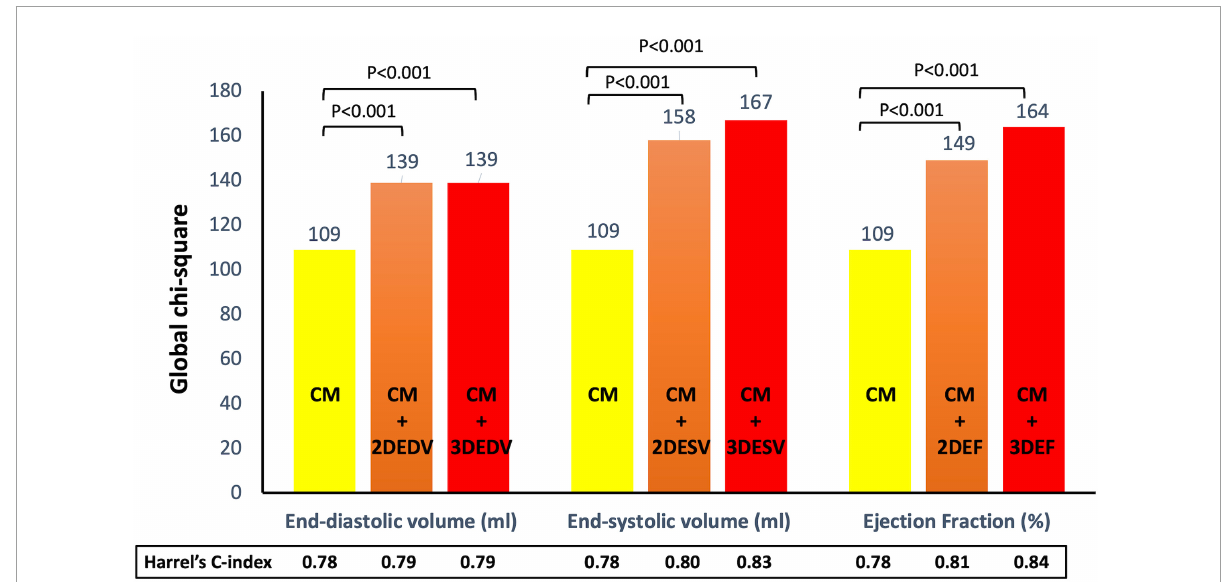
FIGURE5 Addition of left ventricular volumes and ejection fraction obtained from both two- and three-dimensional echocardiography significantly increased the association with all-cause death of the clinical model based on permanent atrial fibrillation, ischemic heart disease, and serum levels of creatinine and hemoglobin. Both three-dimensional end-systolic volume and ejection fraction had stronger association with outcome than the corresponding two-dimensional parameters. CM, clinical model; EDV, end-diastolic volume; EF, ejection fraction; ESV, end-systolic